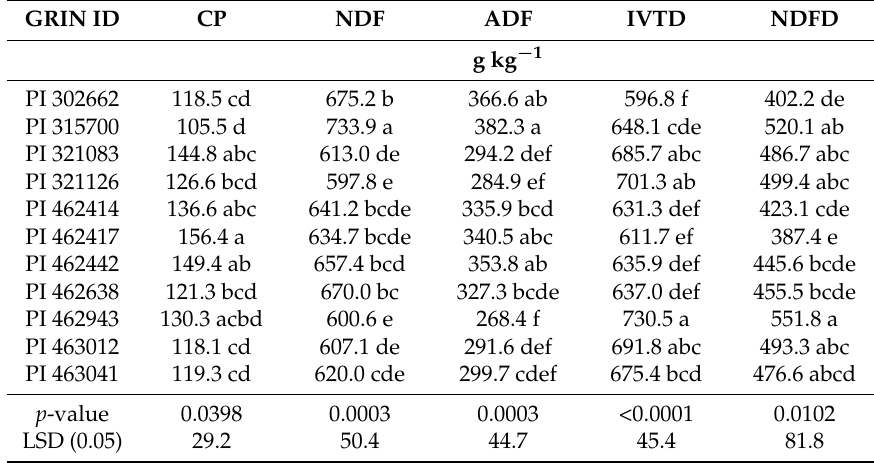
Table 3. Forage nutritive value of whole plant biomass of 11 accessions of finger millet 165 days after planting when all accessions had completed reproduction at El Reno, OK.